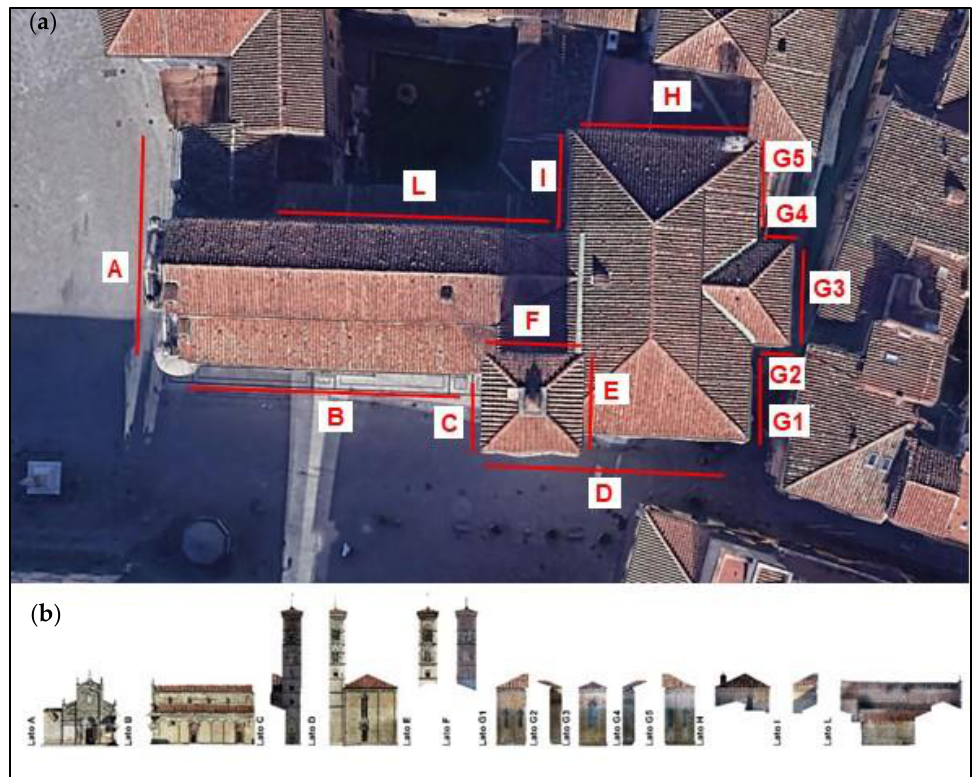
Figure 2. ( a ) Map of the cathedral and bell-tower complex with the side reference (A to L); ( b ) the relative photoplanes.